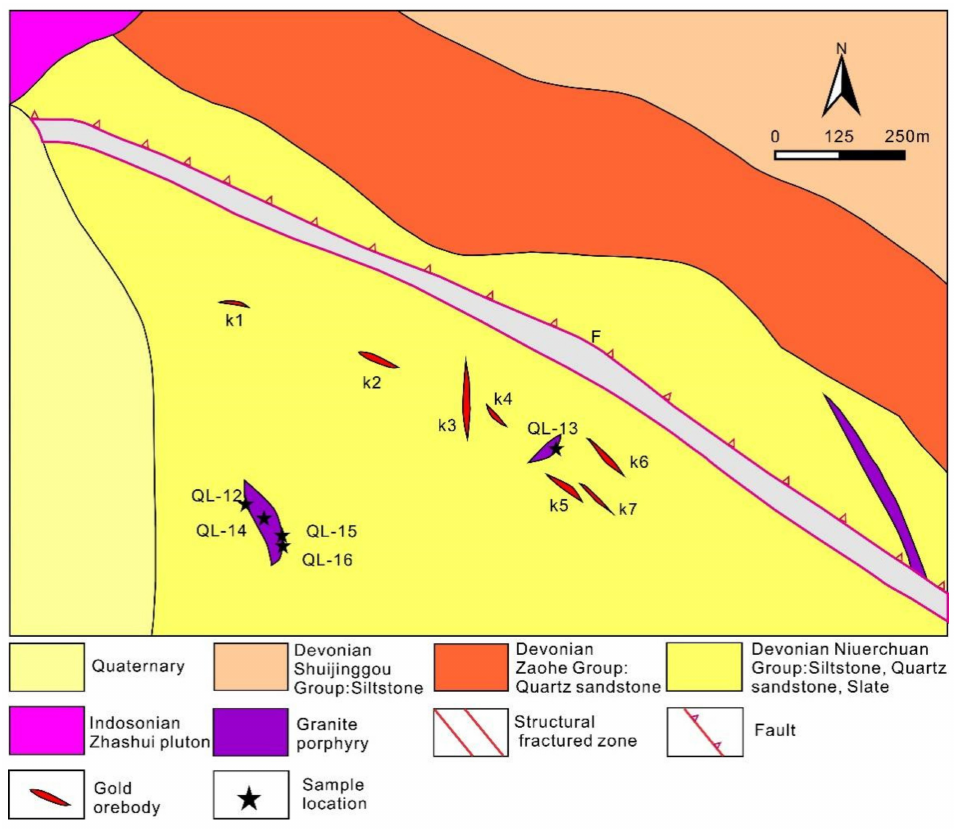
Figure 3. Geologica map of the Qinglingou area in the Zhashui-Shanyang ore district cluster (Modified after No. 713 Geological Team, Northwest Bureau of Geological Exploration for Nonferrous